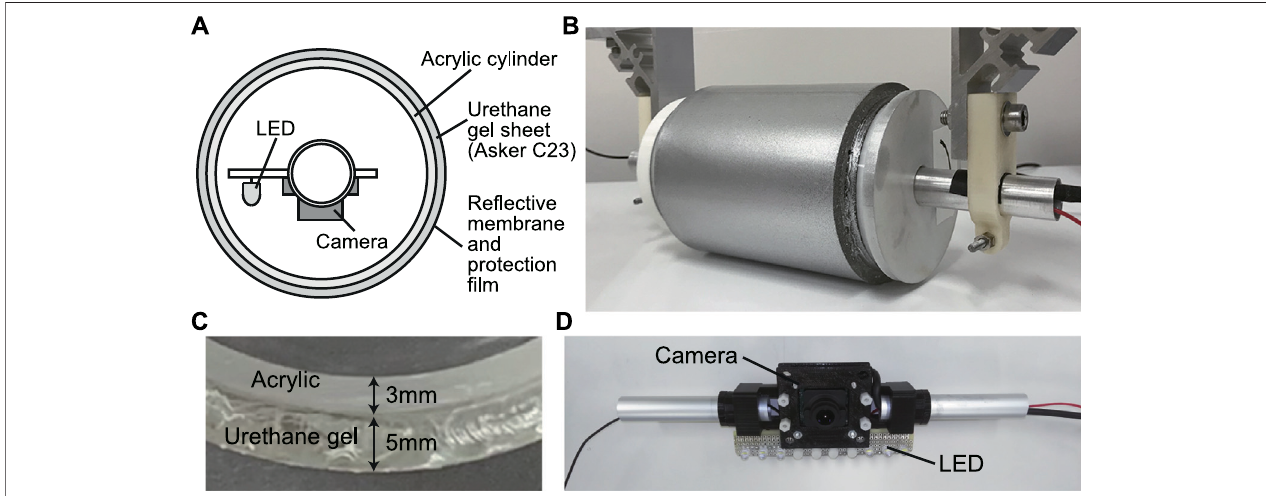
FIGURE2| Thecylindricaltactileimagesensor. (A) internalstructureofthesensorseenfromtheside, (B) pictureofthesensor, (C) enlargedviewofthesensorskin. Outside surface of the urethane gel layer is coated by re fl ective membrane. (D) camera and illumination set in the cylindrical sensor body.